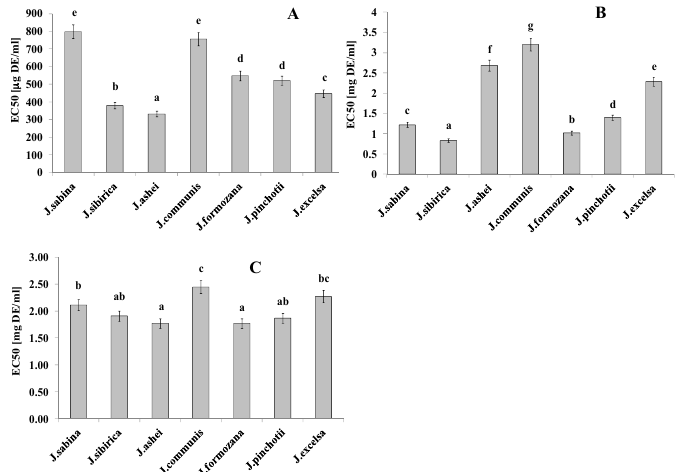
Figure 2. Antioxidant activity of extracts from leaves of previously selected juniper representatives. ( A )—antiradical activity against 2,2 ′ -azino-bis(3-ethylbenzthiazoline-6-sulphonic acid (ABTS), ( B )— chelating power, ( C )—ability to lipoxygenase inhibition. Standard deviation (SD) is shown as error bars. Values (±SD) with different letters (a–g) are significantly different at p < 0.05. Interestingly, despite the similar inhibitory activity, the extracts have different modes of action. The most effective samples acted as uncopettitive LOX inhibitors (Figure 3). Extracts from J. pinchotii and J. excelsa demonstrated a non-competitive mode of action, whereas the weakest inhibitor—extract from J. communis —acted as a competitive LOX inhibitor (Figure 3D,F).